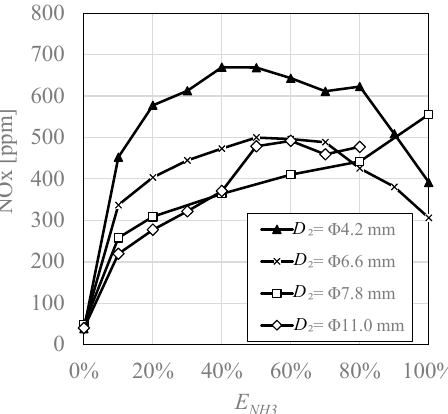
Figure 6. Comparison of NOx for different D 2 . Input = 11.63 kW, λ total = 1.2, L = 100 mm.